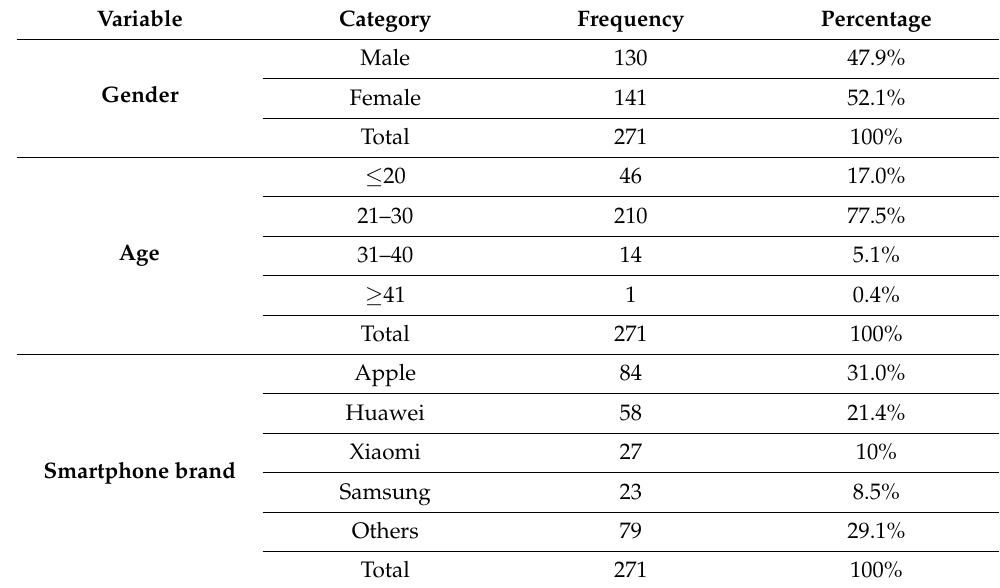
Table 2. Demographic